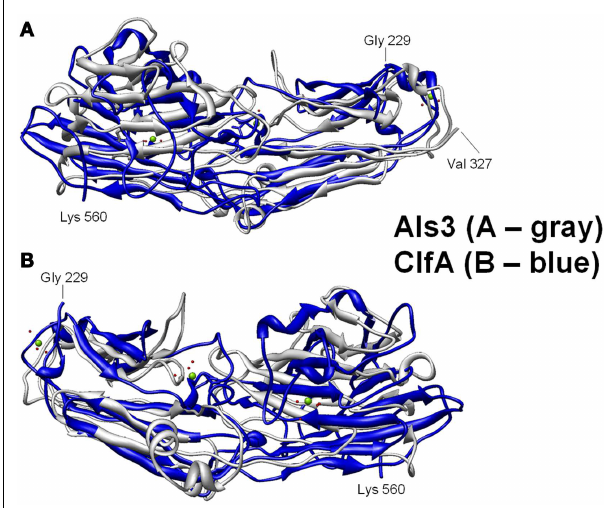
model of Als3 with that of the known structure of ClfA. (A) Front view of the 3-D structural superimposition of homologous structural domains of Als3 ( Candida albicans ; gray) and ClfA ( Staphylococcus aureus ; blue); (B) rear view of the same region in protein homologs.The discovery, prediction, and validation ofT-cell epitopes in such homologs offers further promise in design of innovative convergent vaccine antigens that induce